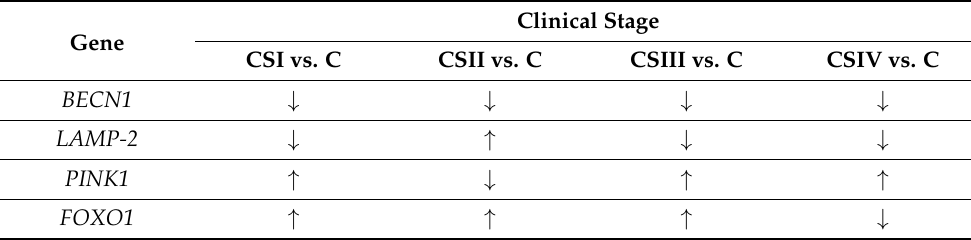
Table 4. Change in the expression of the studied genes determined by RT-qPCR in colorectal cancer and control